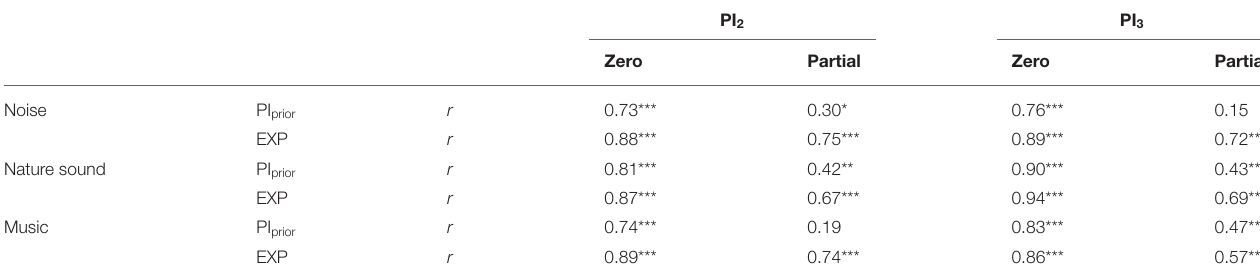
TABLE 1 | Correlations between expected and perceived pain intensity and between prior and perceived pain intensity across auditory